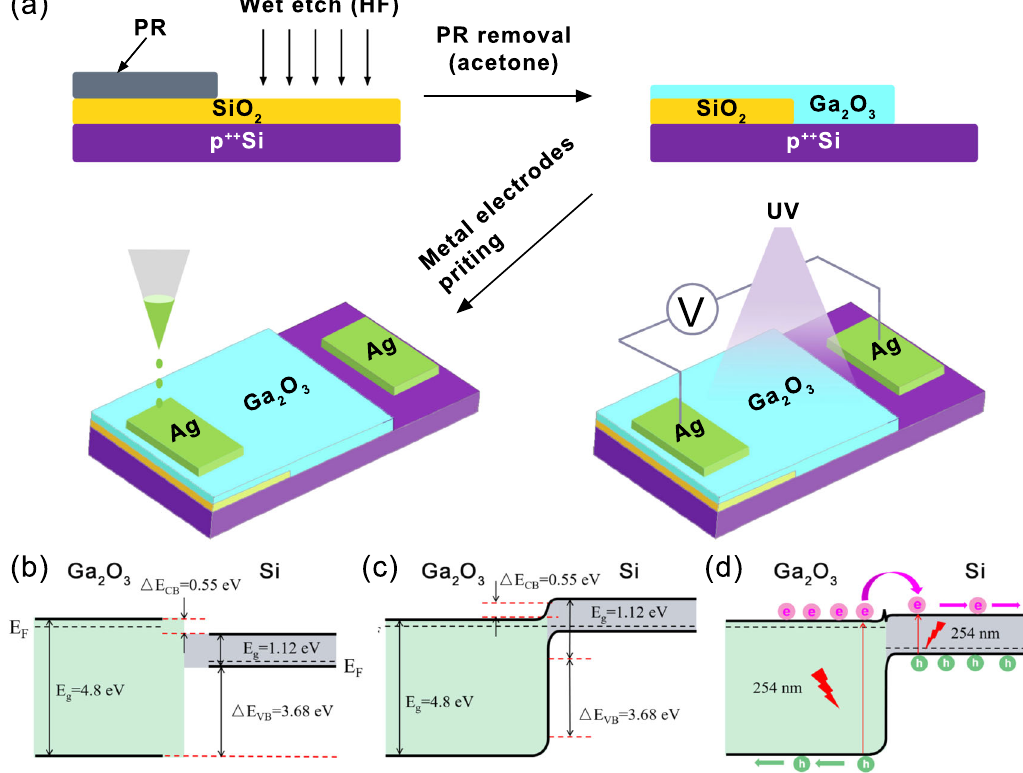
Fig. 5 Schematic image and energy band diagrams of the fully printed Ga 2 O 3 /Si heterojunction photodetector. a Fabrication process of the photodetector. Band diagrams of n-type Ga 2 O 3 and p ++ Si heterostructure indicating b pre-junction creation, c post junction creation, and d under 254 nm